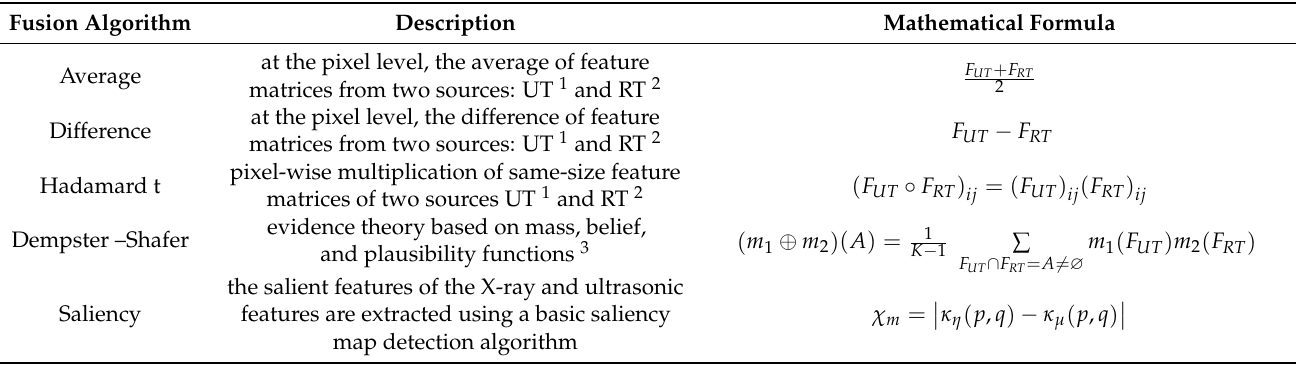
Table 3. Data fusion